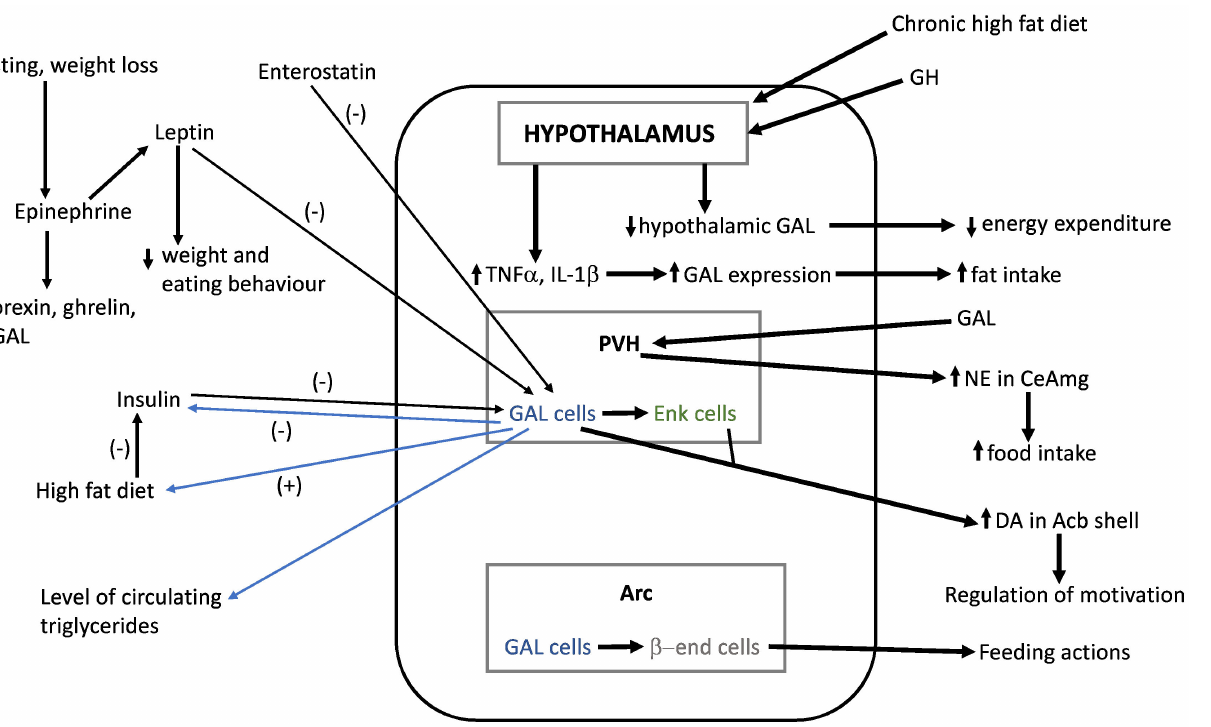
Figure 6. Molecular interactions between GAL and other substances. General interactions (i.e., hypothalamus) are indicated, and more specific actions are signaled separately. Actions mediated specifically by GAL are represented by blue